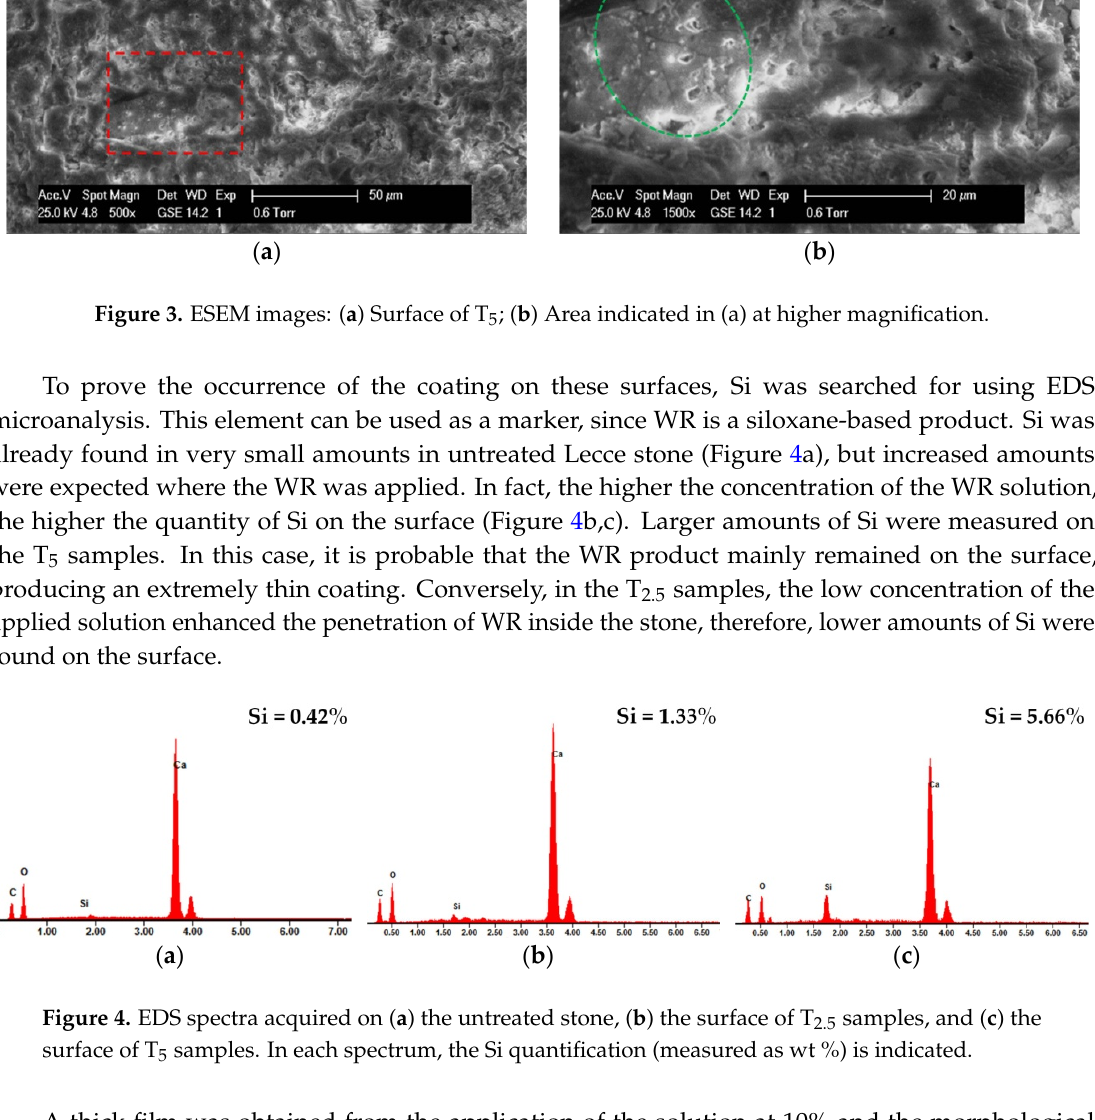
Figure 4. EDS spectra acquired on ( a ) the untreated stone, ( b ) the surface of T 2.5 samples, and ( c ) the surface of T 5 samples. In each spectrum, the Si quantification (measured as wt %) is indicated.